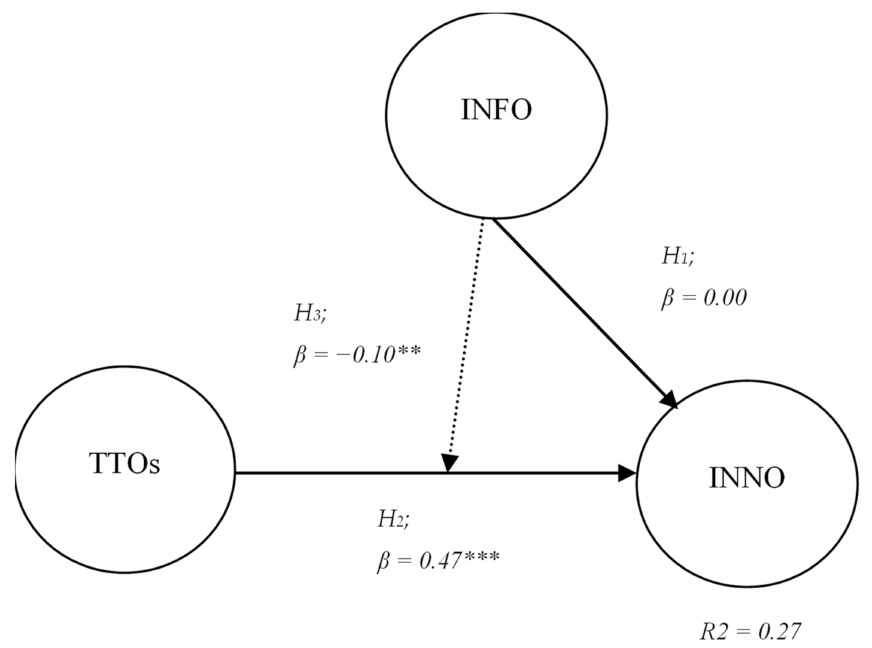
Figure 3. Structural model. Source: Authors. *** p < 0.05; ** p <